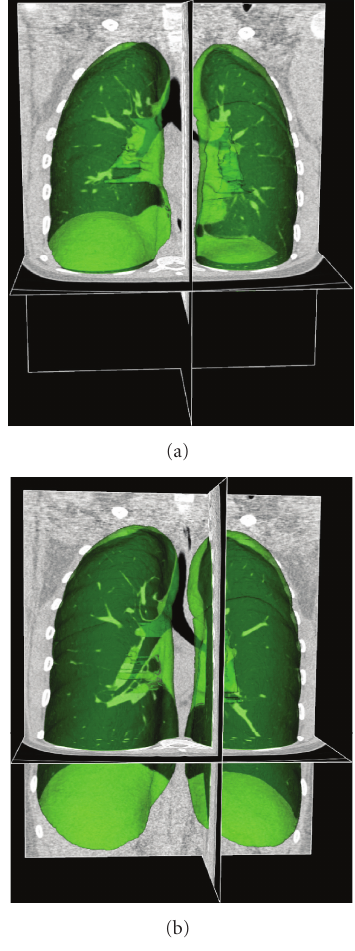
Figure 1: Pulmonary CT images acquired at breath hold (a) maxi- mum exhale and (b) maximum inhale with renderings of the lung segmentations (green